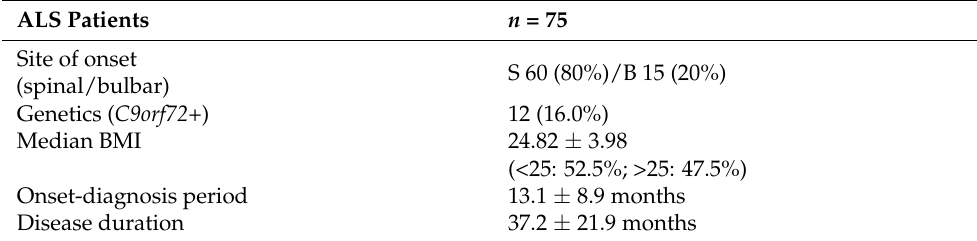
Table 2. Clinical variables of ALS